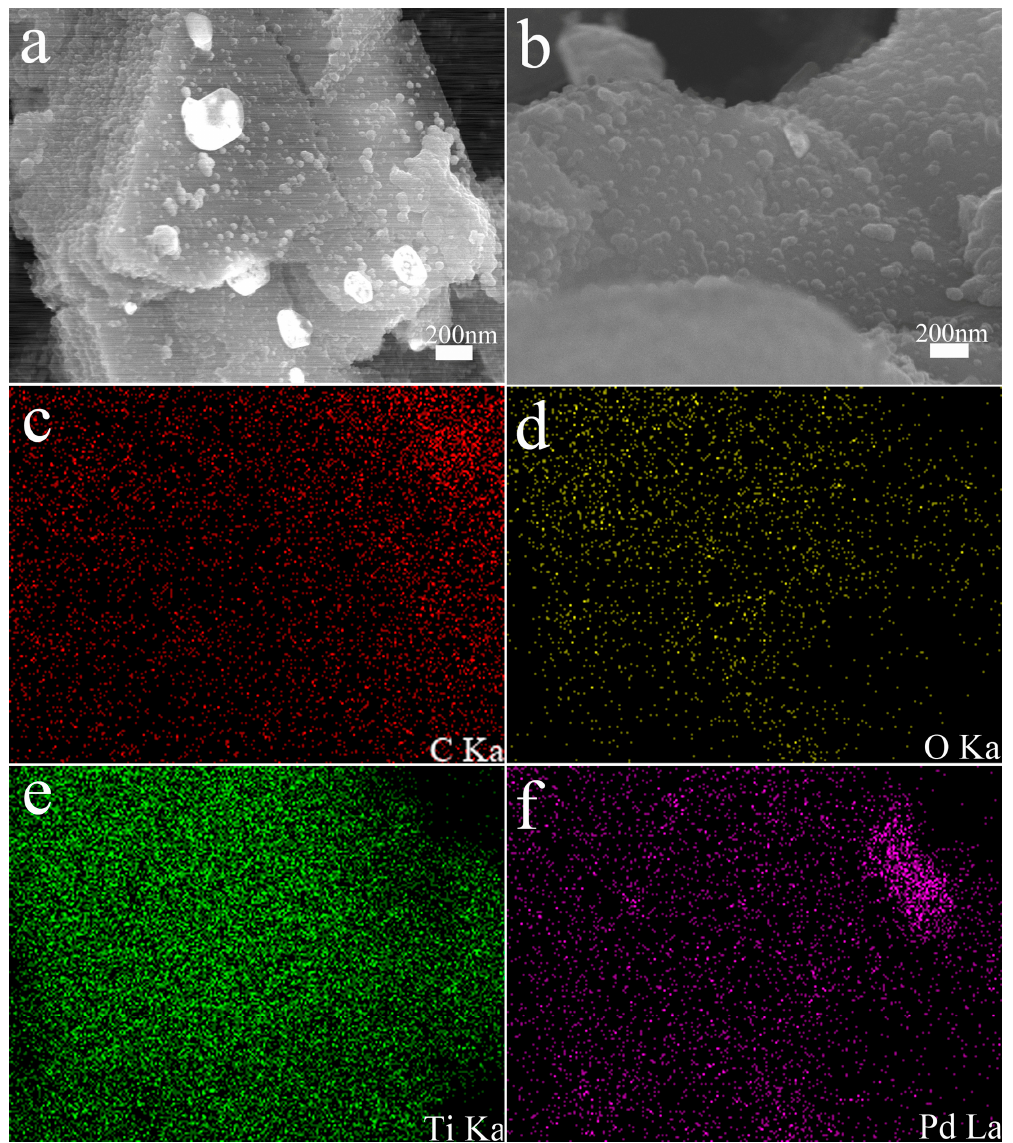
Figure 4. Representative SEM image of layered MXene@PdNPs5 ( a ) and MXene@PdNPs20 ( b ) with C/O/Ti/Pd elemental mapping ( c – f ).